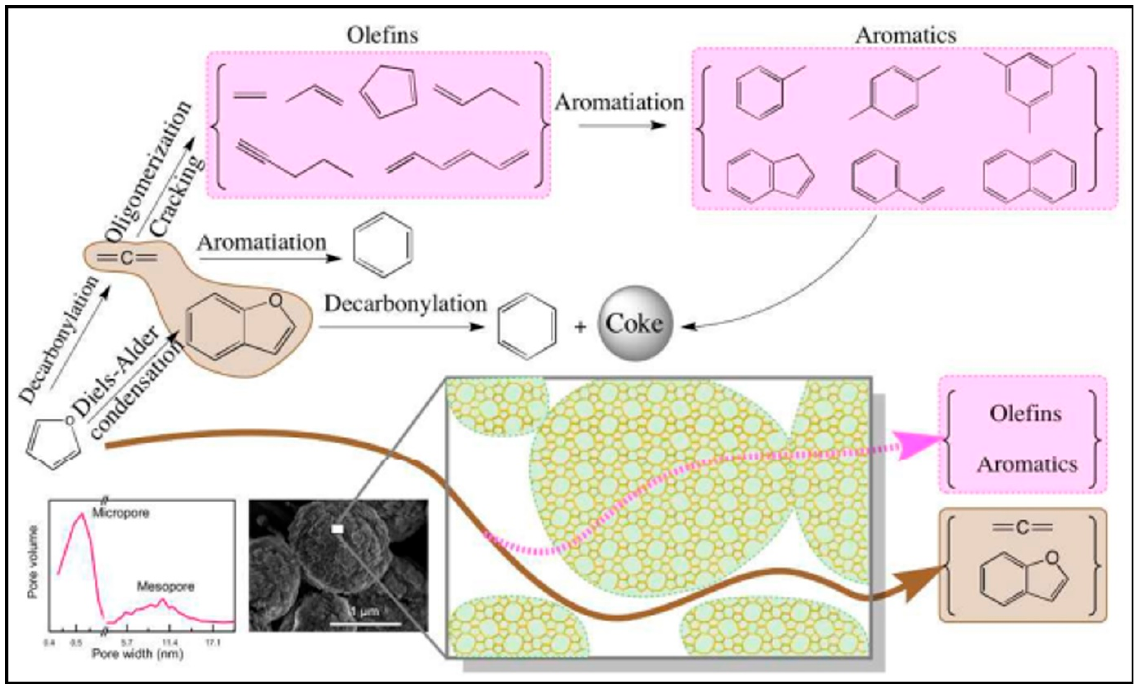
Figure 7. Furan conversion with the assistance of meso ZSM-5 catalyst (Gou et al., 2017, copyright 2014, The Royal Society of Chemistry) [129].